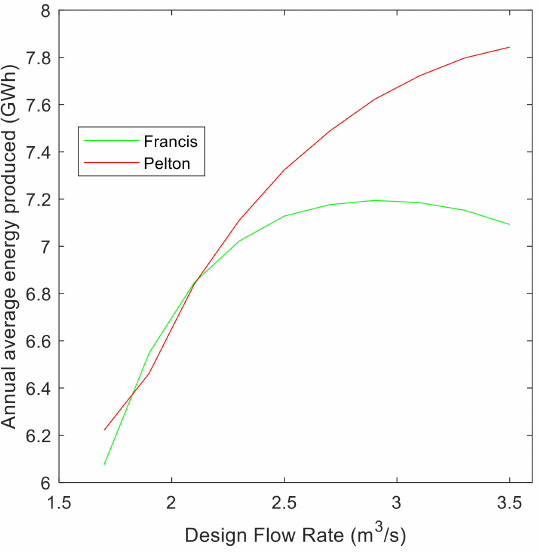
Figure 8. Annual average energy produced (GWh) at varying designed flow rates at a constant head of 70 m for the Francis and Pelton turbines.